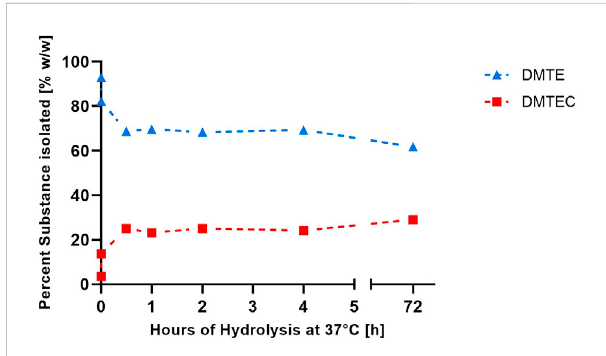
FIGURE 1 Percent weight/weight of DMTE and DMTEC isolated from the simulated gastric media (pH 1.2 ° C and 37 ° C) from zero to 72 h.